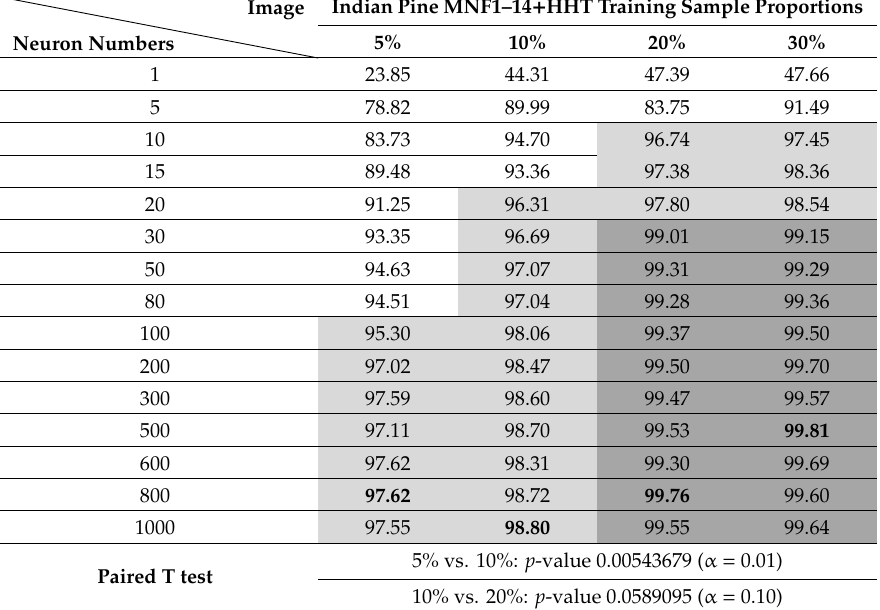
Table 2. Classification accuracy results of IP MNF1–14 + HHT image set with di ff erent training sample proportions using 1 to 1000 neurons. The highest accuracy value in the corresponding training sample proportion column is shown in bold, and values above 95% are shaded in light gray. In comparison, the value above 99% is shaded in dark